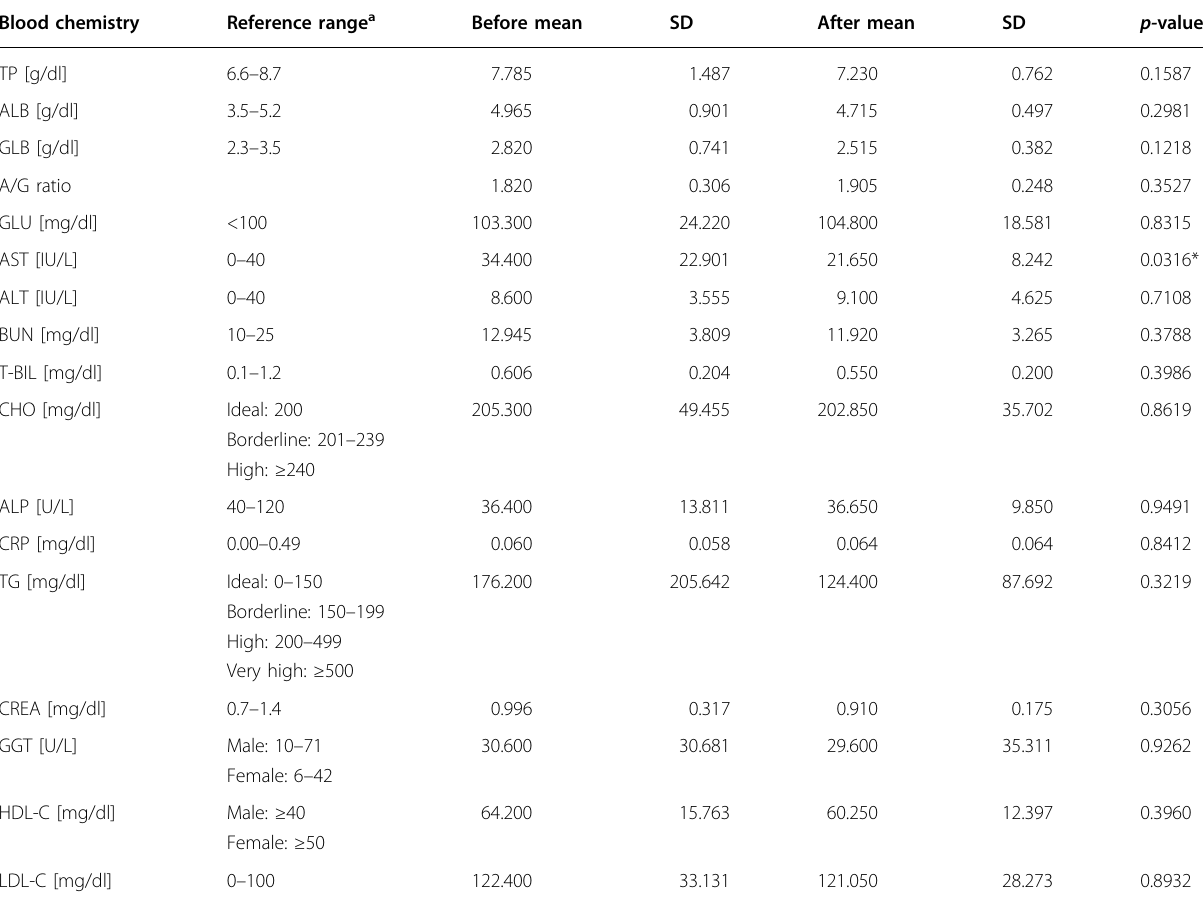
Table 1 Blood chemistry before and after synbiotic beverage consumption Blood chemistry Reference range a Before